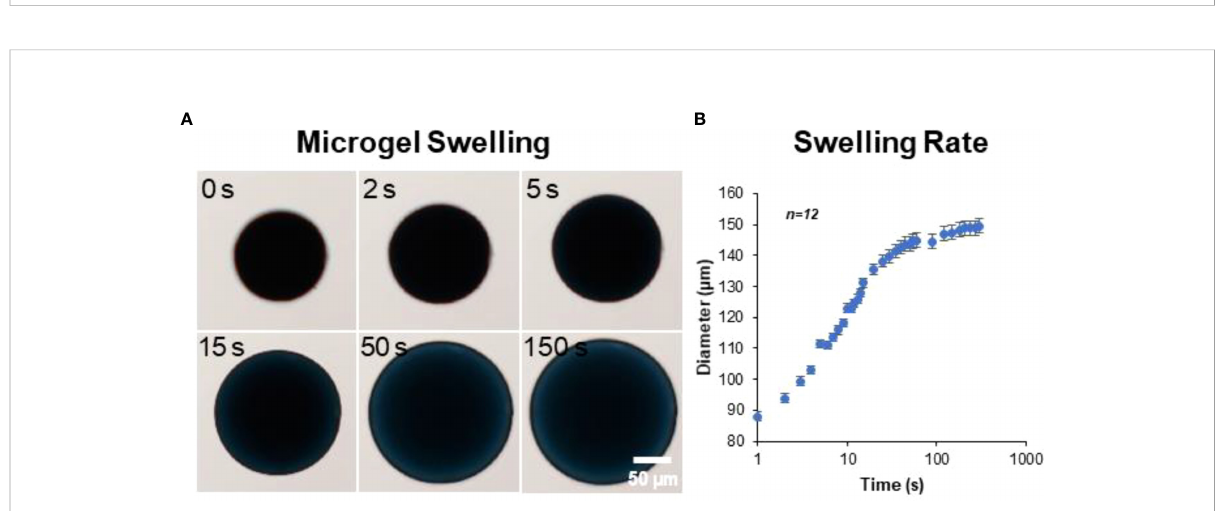
FIGURE 3 Microgel hydration and swelling. The microgels exhibited rapid swelling in an aqueous medium. (A) Time-lapse bright- fi eld images showing microgel being hydrated in PBS. (B) The rate of hydration was rapid initially and plateaued within minutes to achieve an equilibrium state (n = 12).